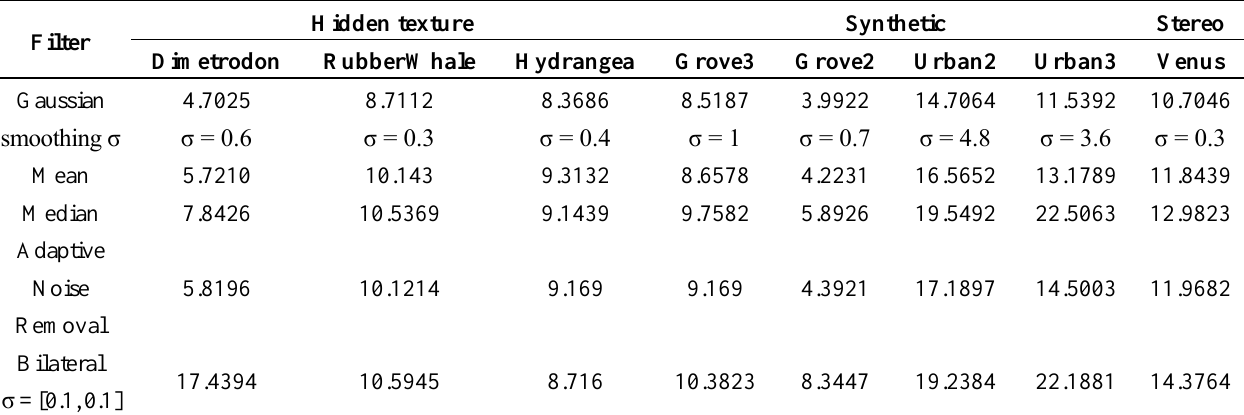
Table 1. Lowest average endpoint error for best performing